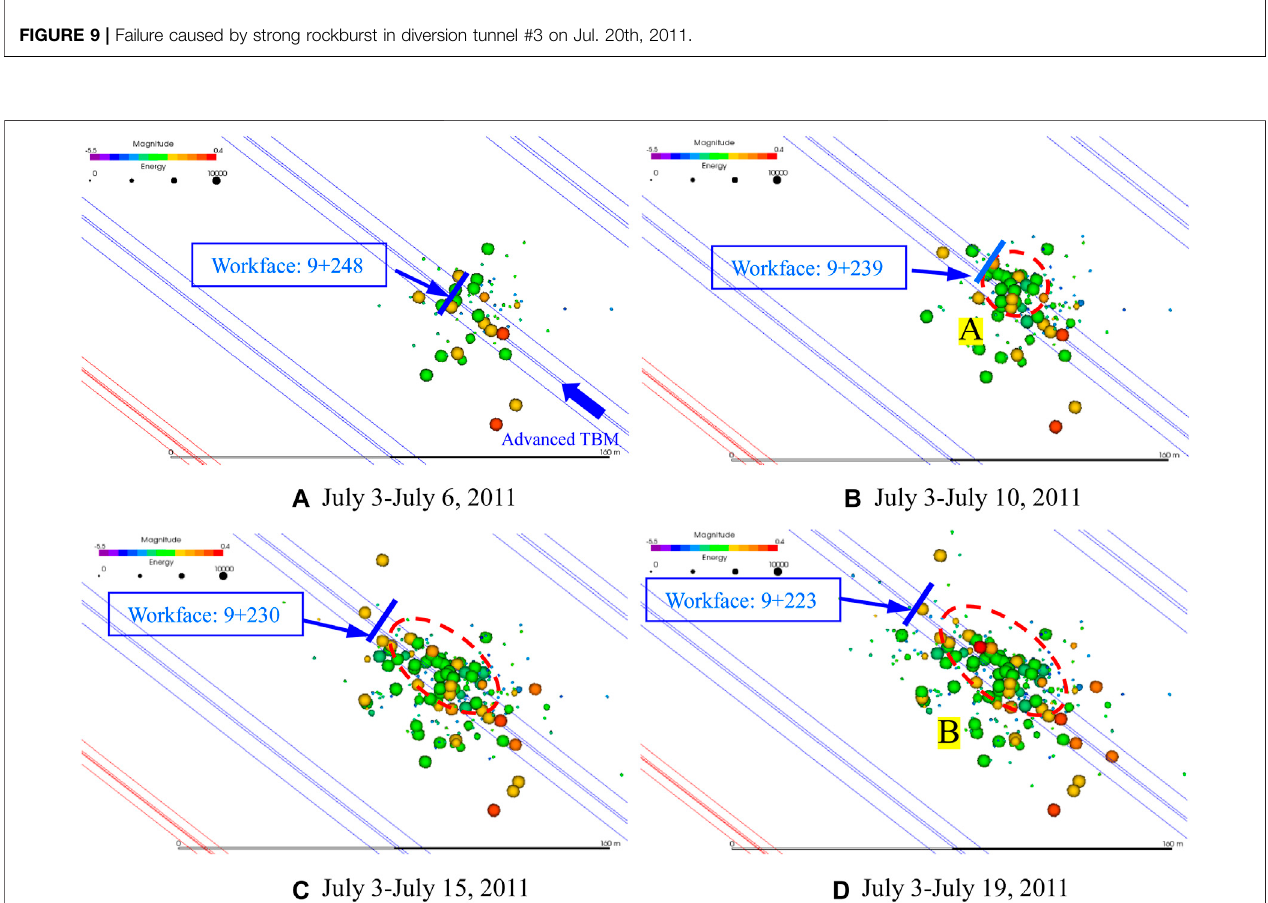
FIGURE 10 | The spatio-temporal distribution of MS in diversion tunnel